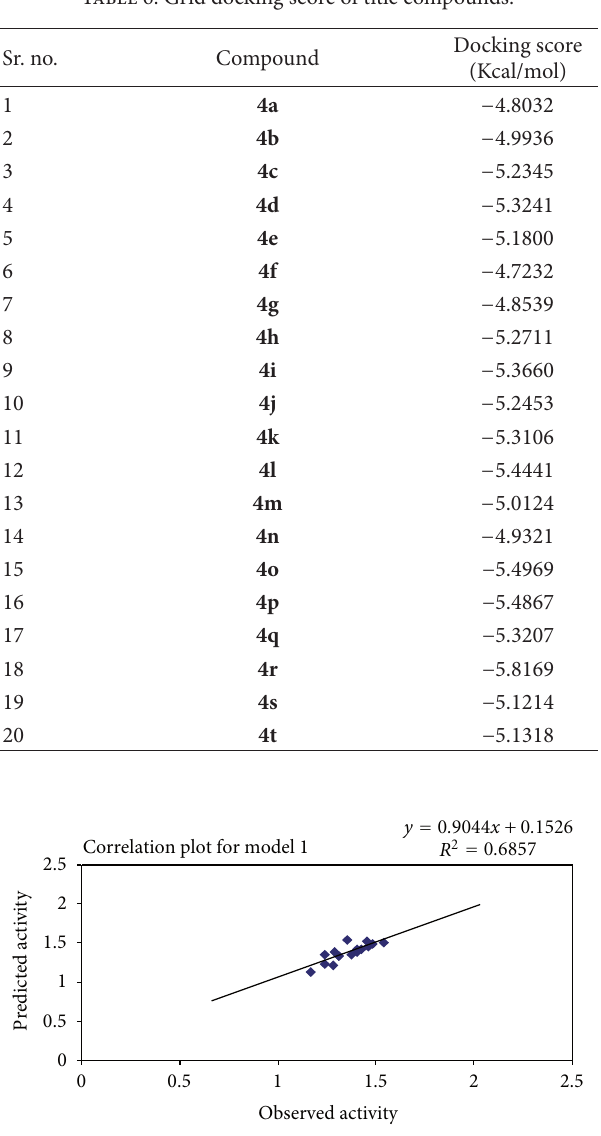
F 5: Plot of predicted against observed tyrosinase inhibition activity (model 1).